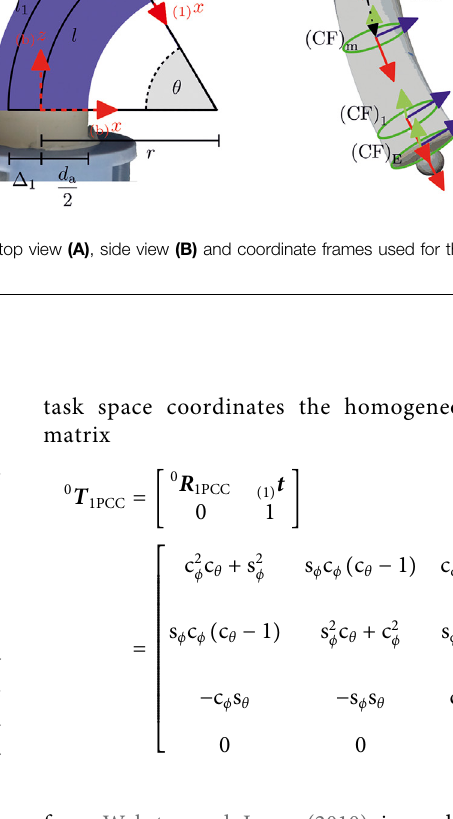
Frontiers in Robotics and AI |